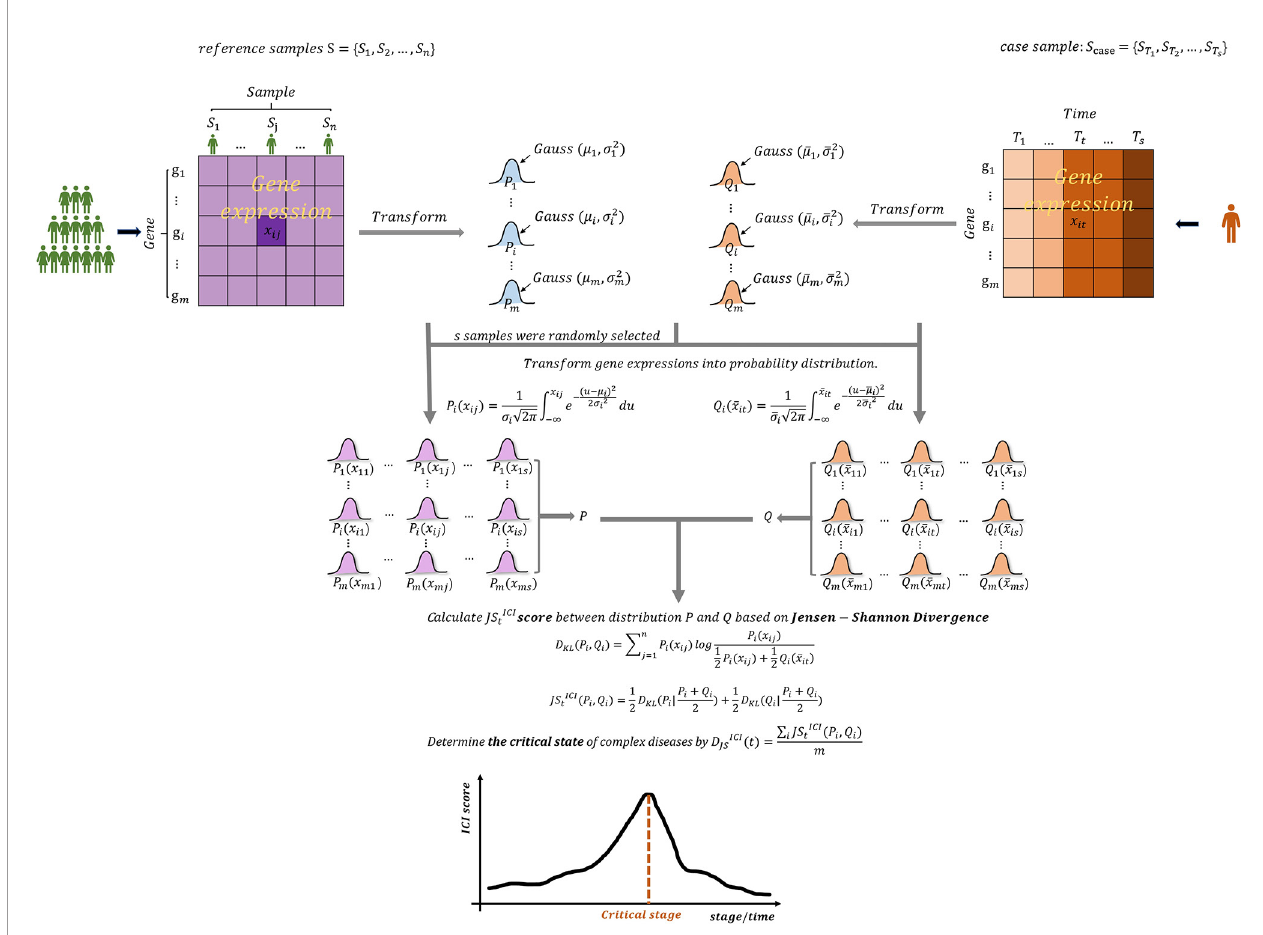
FIGURE 2 | The outline for detecting early warning signal of pre-disease state based on sJSD. Given reference samples and case samples, the Gaussian distribution was fi tted for each gene, and the probability distribution area was converted. The inconsistency index (ICI) which can be used to identify early-warning signals for deterioration of complex diseases are constructed based on the sJSD